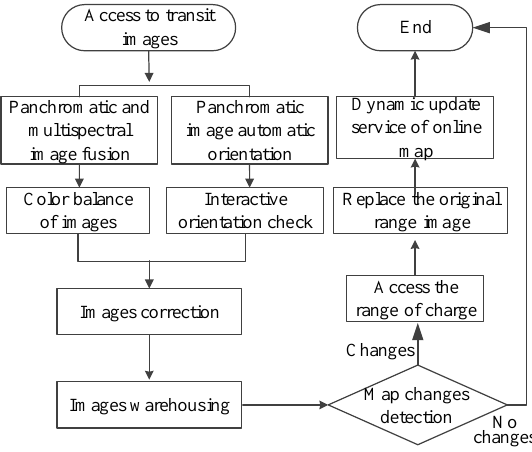
Figure 2. Flow chart of intelligent image processing technology